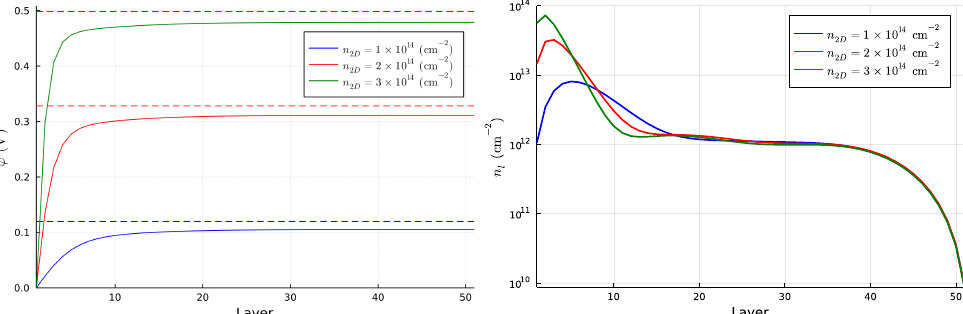
Figure 3. ( Left panel ) Behaviour of ϕ as a function of the layer position for each benchmark choice of n 2 D . The dashed line represents the corresponding Fermi level. ( Right panel ) Electron density as a function of the layer position for every benchmark value of n 2 D